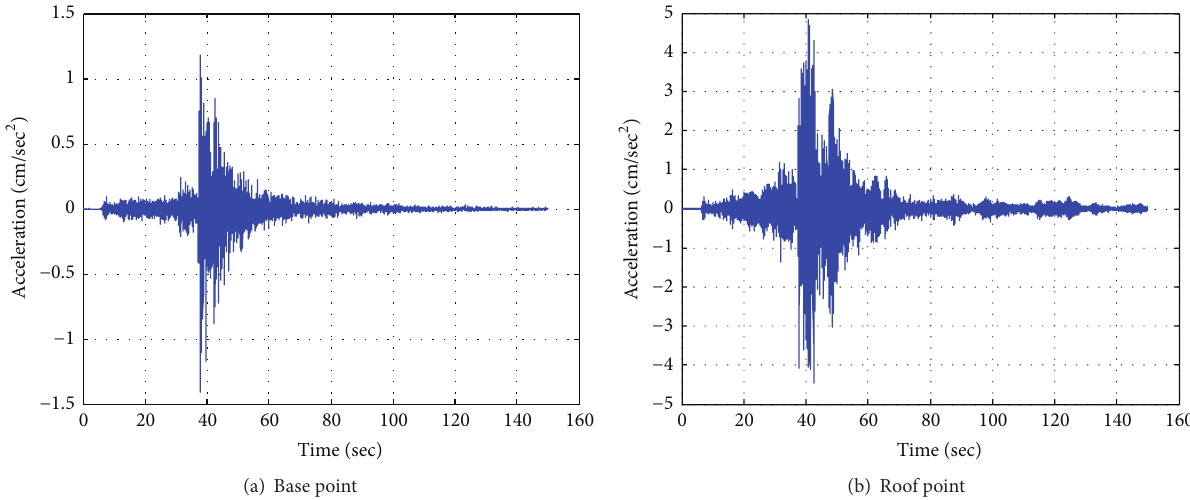
Figure 13: Acceleration response measurements in 𝑋 direction during the earthquake shaking.